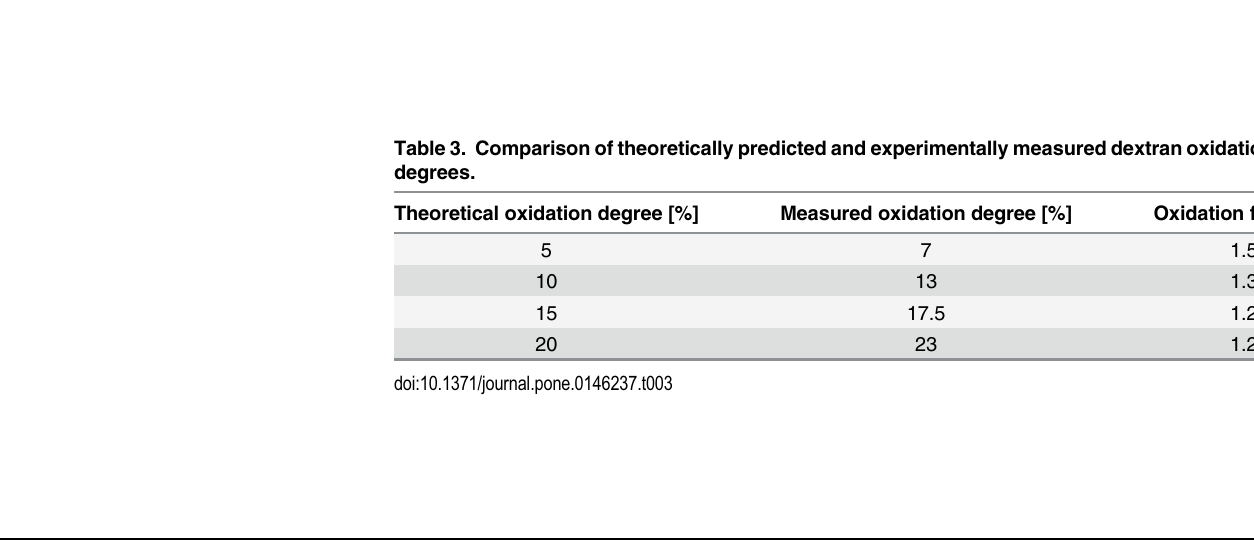
Fig 2. Scheme of dextran modifications. Step 1: Oxidation, leading to opening of the glucose rings. Step 2: Schiff base formation between glucose carbonyl group and aliphatic amine.